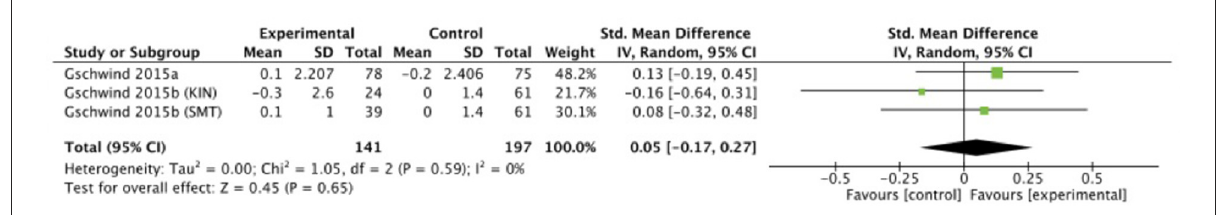
FIGURE10 Random effects meta-analysis forest plot for effectiveness of intervention on measures of DSB cognitive performance outcomes.